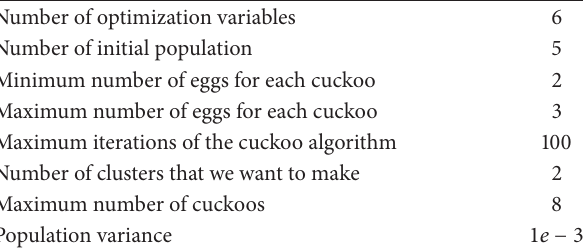
Table 1: Values of COA